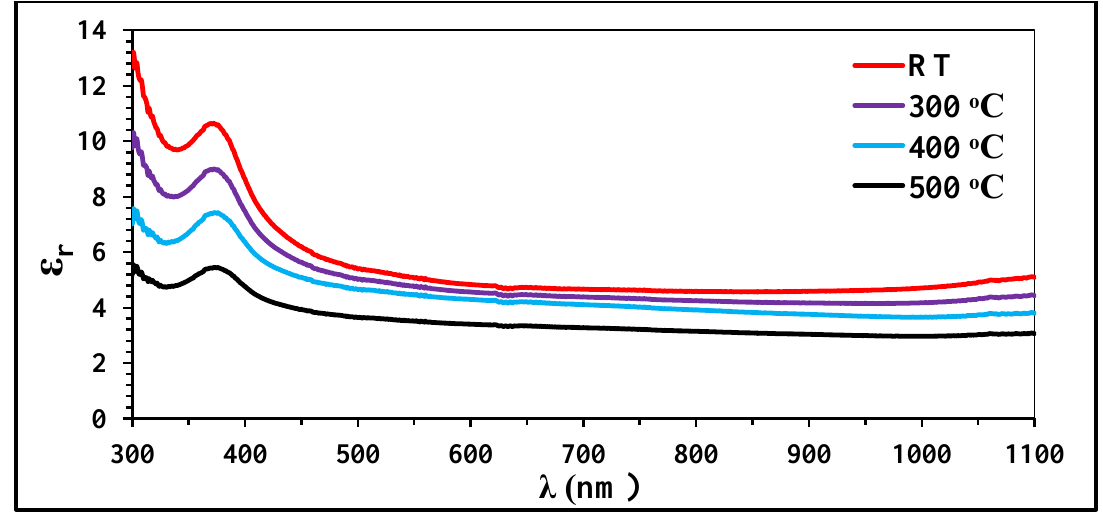
Fig. 10: The real part of dielectric constant of the Cr